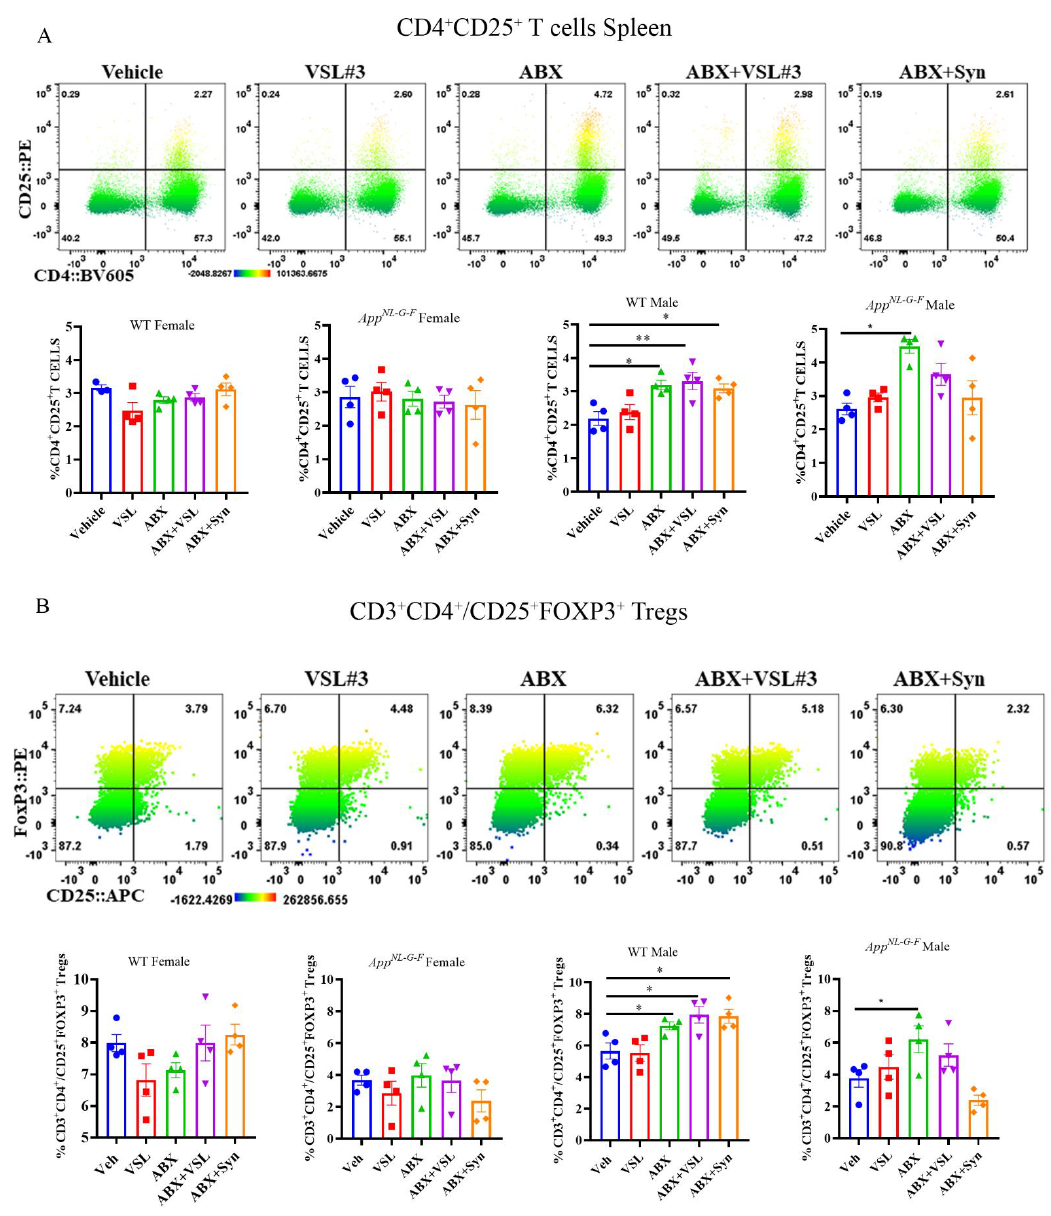
Figure 10. Upregulation of CD4 + CD25 + T and FoxP3 expressing CD4 + CD25 + T regulatory cells following antibiotics treatment in male WT and App NL-G-F mice. ( A ) Splenocytes were stained with surface markers directed against a panel of T cell markers and measured by flow cytometry. Representative heat map dot plots from male App NL-G-F mice showing the percentage of CD4 + CD25 + T cells gated on viable CD45 + CD3 + cells. Numbers in each quadrant indicate the percentage of cells. The heat map color varies from blue to red, indicating relative under and over-representation of the percentage of cells, respectively. Bar graphs display mean ± SEM of the percentage of CD4 + CD25 + T cell across different treatment groups in female and male C57BL/6 (WT) and App NL-G-F mice ( n = 3–4 mice/group). Statistically significant differences were computed by one-way ANOVA, * p < 0.05, ** p < 0.005. ( B ) Splenocytes were stained with surface markers directed against a panel of T cell markers and measured by flow cytometry. Representative heat map dot plots from male App NL-G-F mice showing the percentage of CD25 + FoxP3 + Tregs gated on viable CD45 + /CD3 + CD4 + cells. Numbers in each quadrant indicate the percentage of cells. The heat map color varies from blue to red, indicating relative under- and over-representation of the percentage of cells, respectively. Bar graphs display mean ± SEM of percentage of CD25 + FoxP3 + Tregs across different treatment groups in female and male C57BL/6 (WT) and App NL-G-F mice ( n = 3–4 mice/group). Statistically significant differences were computed by one-way ANOVA, * p < 0.05, ** p <